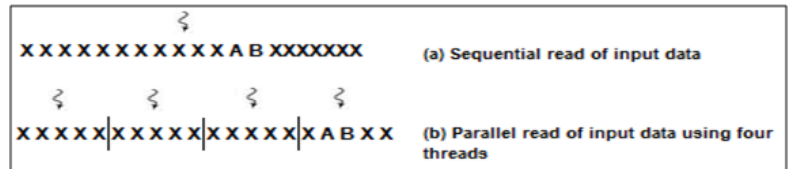
Figure 2: Sequential vs. parallel search.